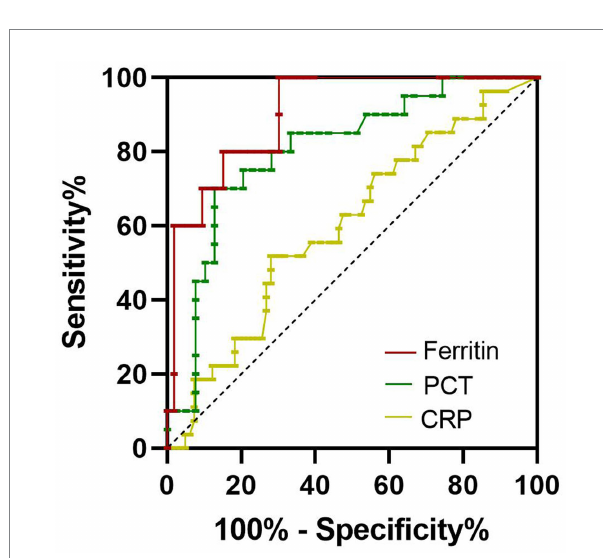
FIGURE 3 Receiver operating characteristics curves showing the performance of ferritin, PCT, and CRP to predict the mortality of SFTS patients at 7–9 days from symptom onset. The AUC of serum ferritin = 0.9057, the AUC of serum PCT = 0.8058, the AUC of CRP =